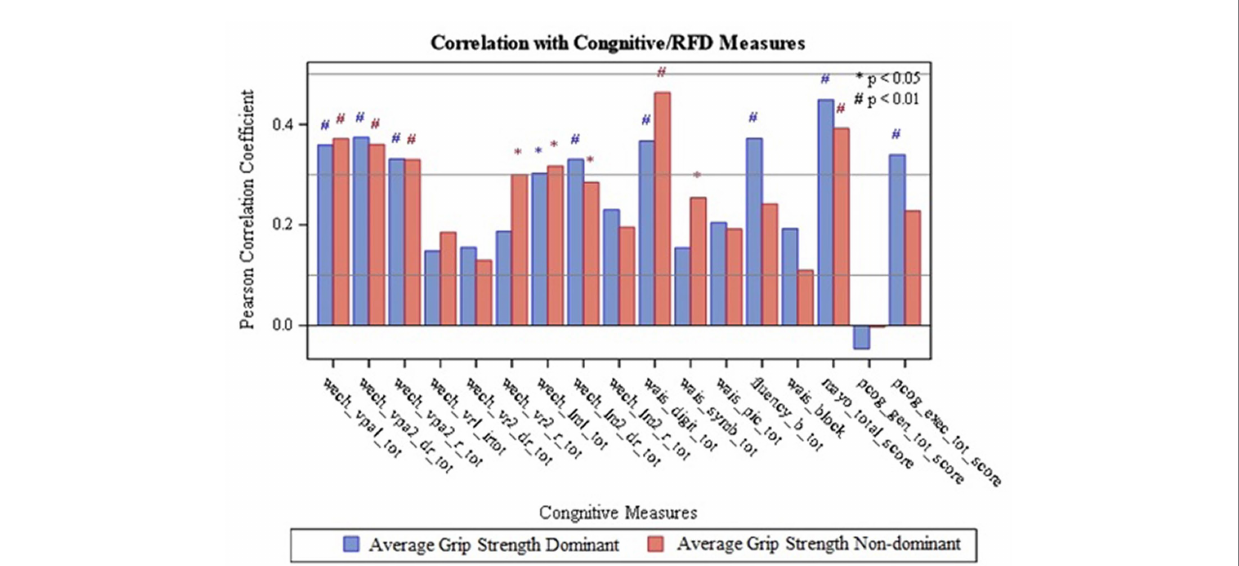
FIGURE 3 Correlation of Grip strength with Cognitive Measures; wech_vpal_tot — Total Visual Paired Associates I — Immediate Recall Raw Score; wech_vpa2_ dr_tot — Total Verbal Paired Associates II-Delayed Recall Raw Score; wech_vpa2_r_tot — Total Verbal Paired Associates II- Recognition Raw Score; wech_vrl_irtot — Total Visual Reproduction I — Immediate Recall Raw Score; wech_vr2_dr_tot — Total Visual Reproduction II - Delayed Recall Raw Score; wech_vr2_r_tot — Total Visual Reproduction II — Recognition Raw Score; wech_Im1_tot — Total Logical Memory I- Immediate Recall